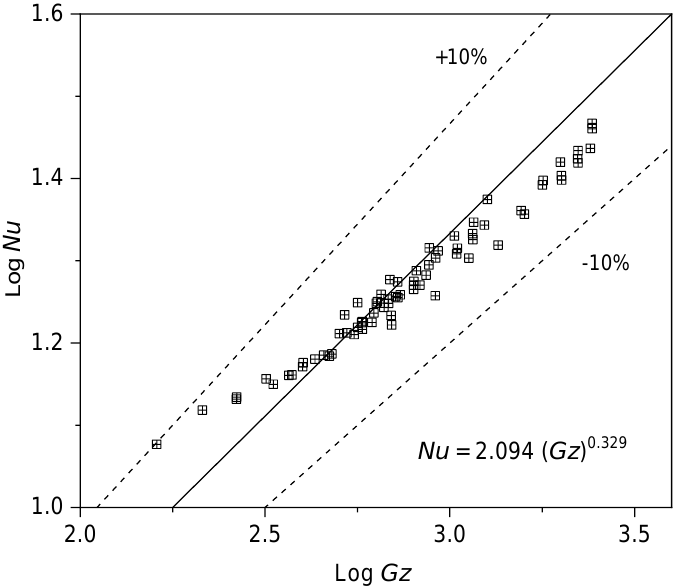
Figure 15. A new convective correlation curve for laminar flow regime in sub-channel vertical square.